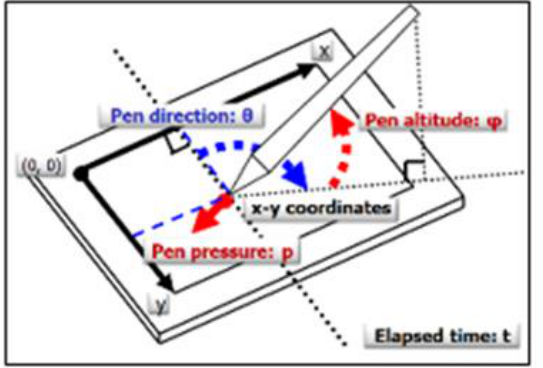
Figure 2. Wacom Tablet Sample Model.